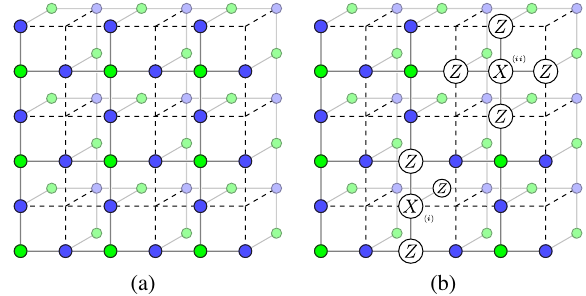
FIG. 7. (a) The lattice at the primal boundary. Primal qubits are depicted in green, while dual qubits are depicted in blue. (b) The primal boundary Hamiltonian H consists of cluster terms, as P depicted by (i) and (ii). Bold lines indicate nearest-neighbor relations between qubits, while dashed lines indicate edges of the ambient cubic